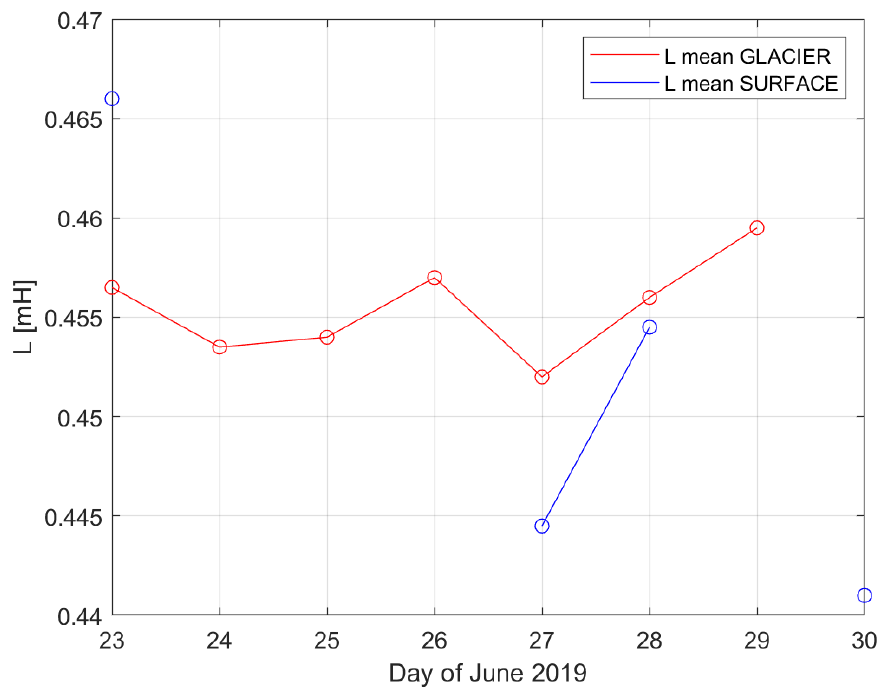
Figure 4. Averaged values of the antennas’ inductances.